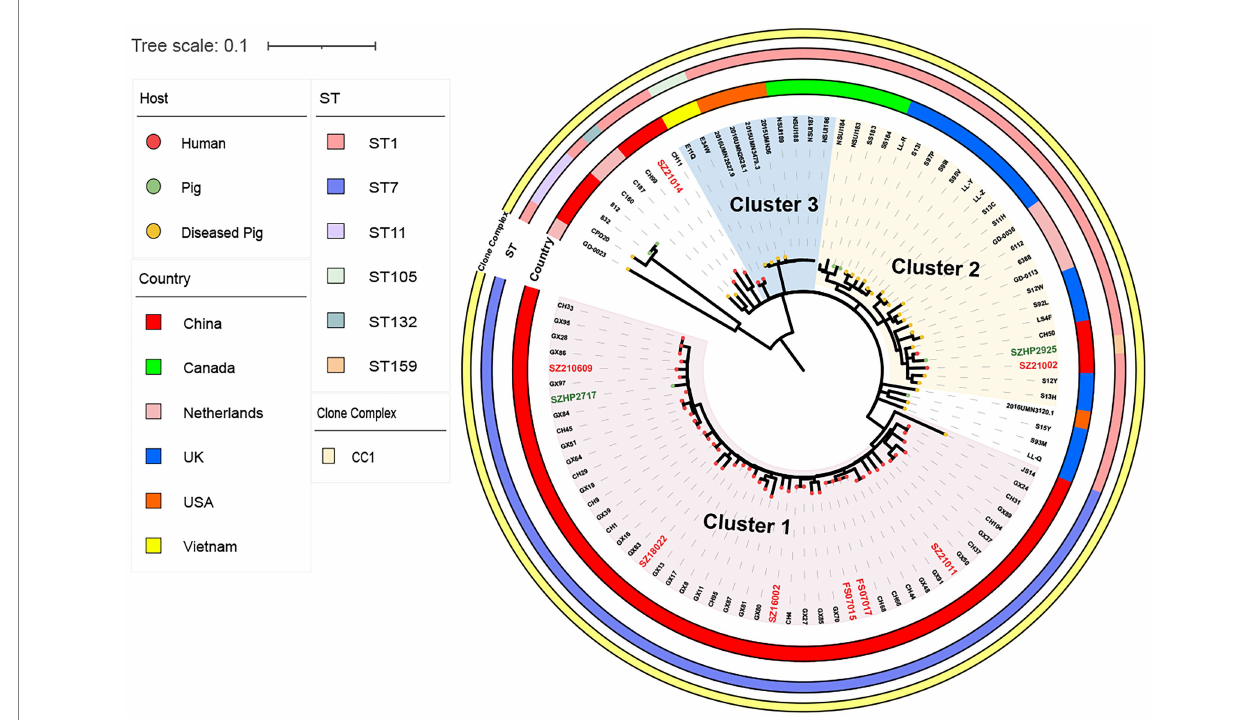
FIGURE 3 Single-nucleotide polymorphism (SNP)-based global S. suis 14 Ml tree includes eight human isolates (red font) and two swine isolates from Shenzhen (green font), and 86 S. suis isolates downloaded from the NCBI database. The different colored circles on each branch represent different host sources, the circles represent clonal complex, ST, or country, as indicated on the